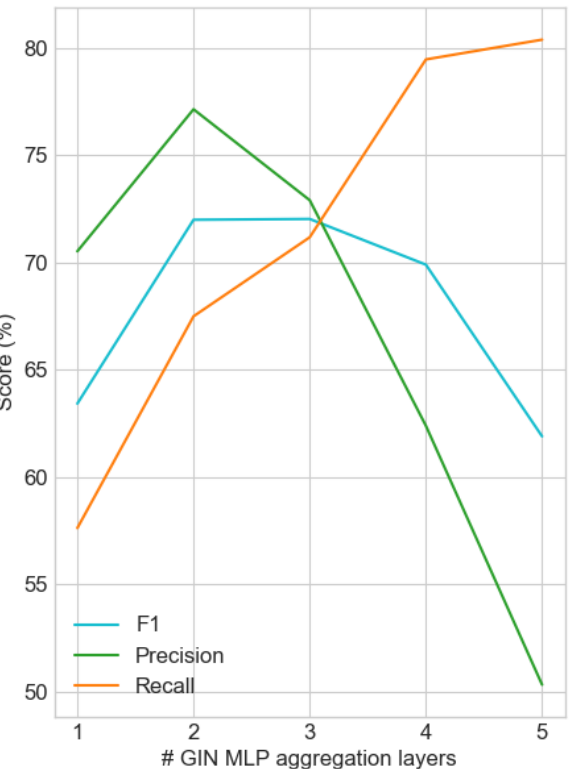
Figure 4. GIN MLP performance compared to the number of aggregation layers using the baseline BioBERT and no additional MLP